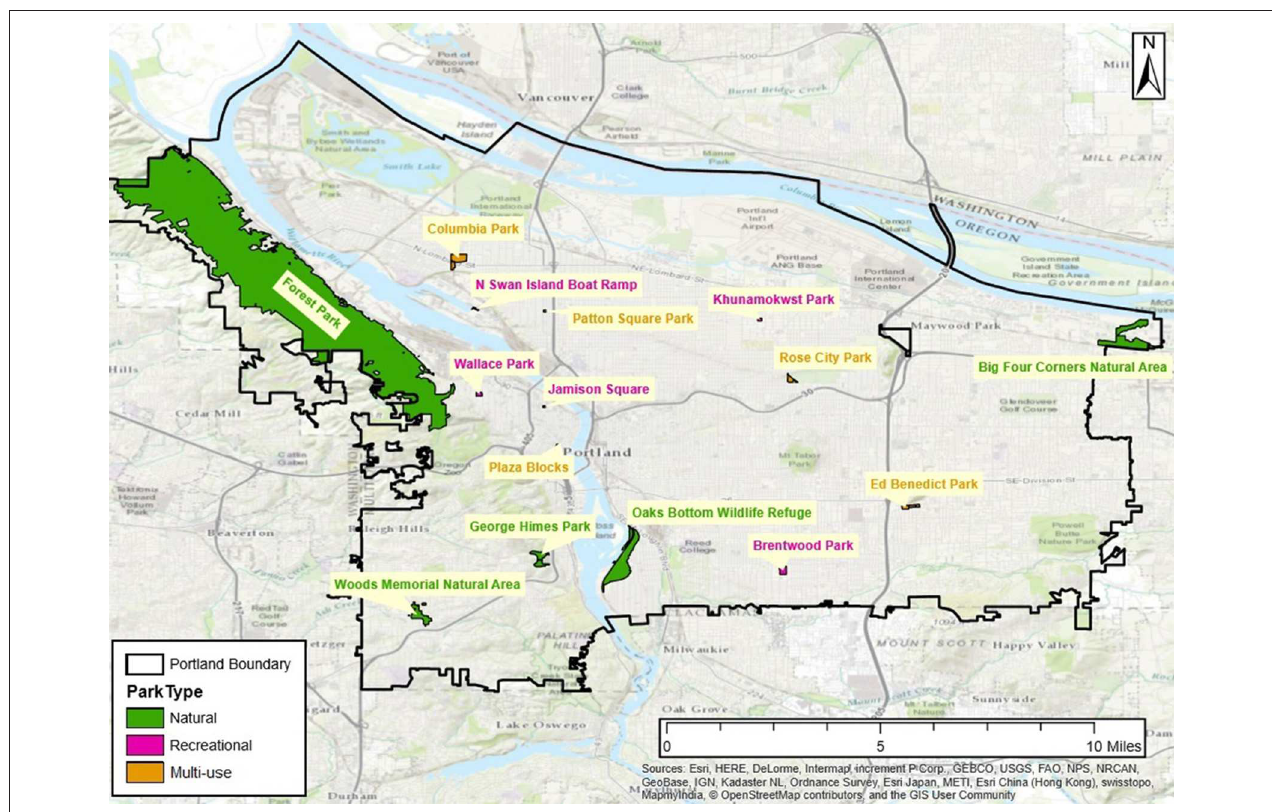
FIGURE 1 | Portland park study sites by type.